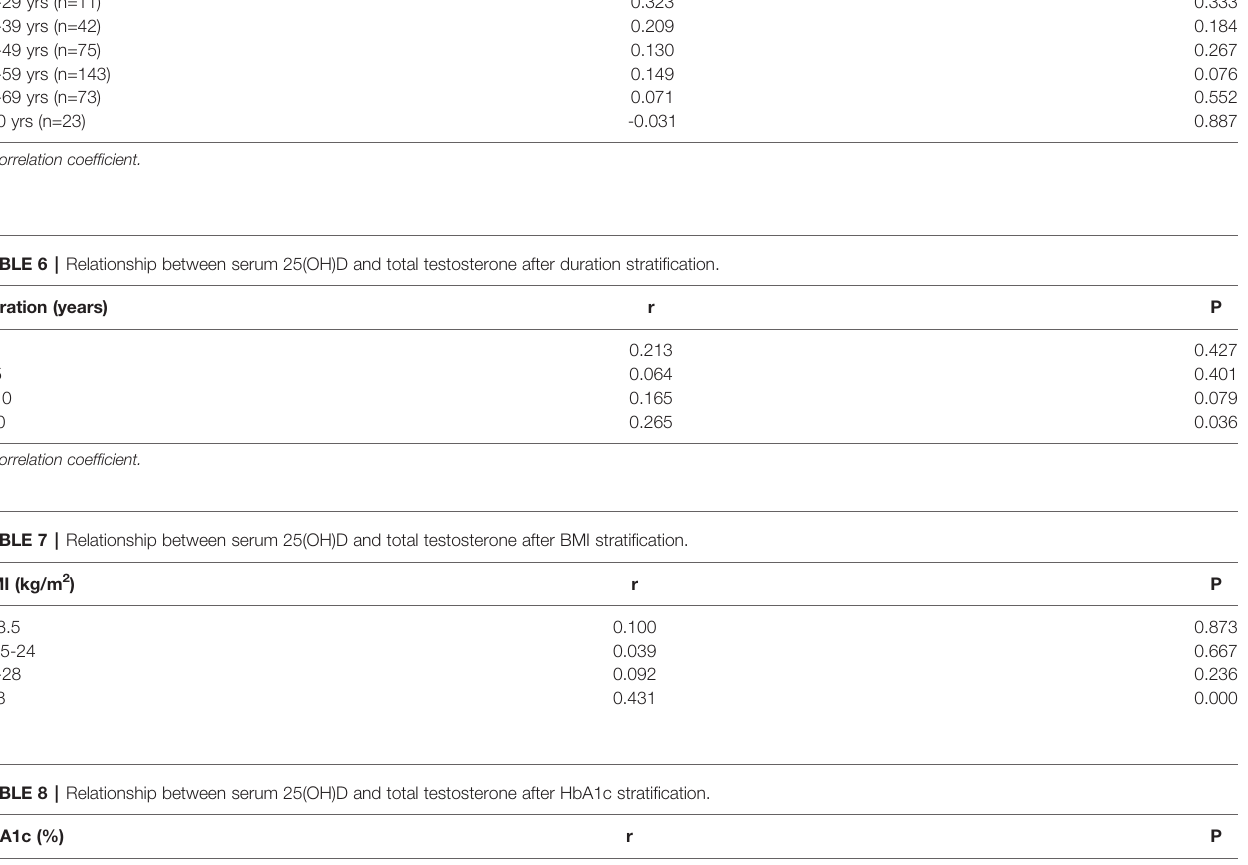
TABLE 5 | Relationship between serum 25(OH)D and total testosterone after age strati fi cation. Age r P 20-29 yrs (n=11)